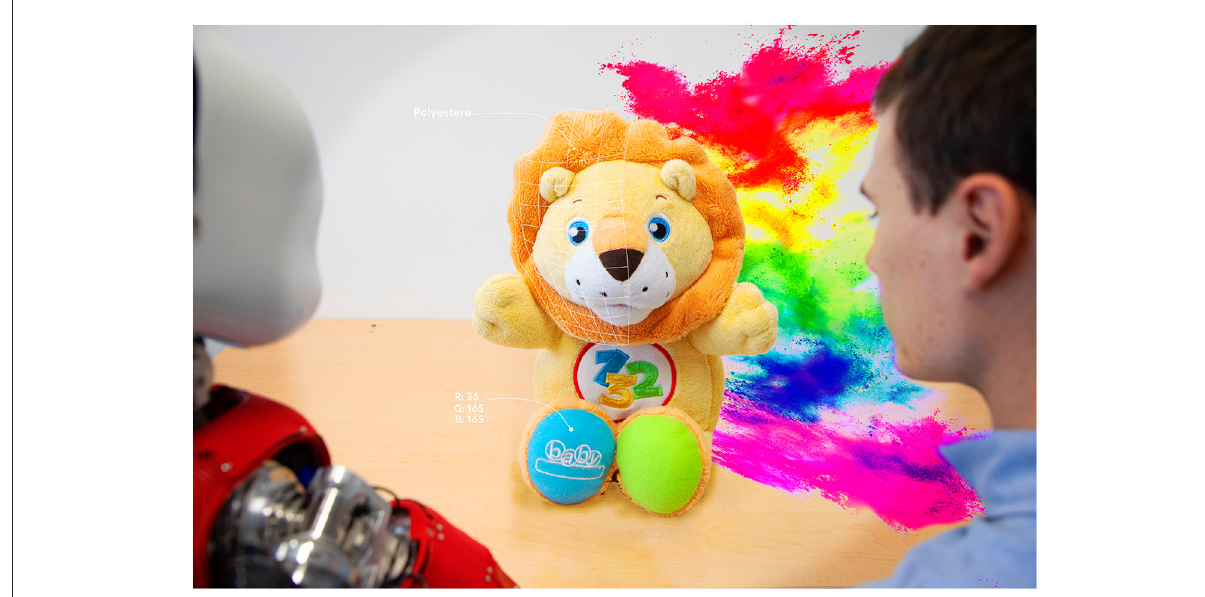
FIGURE1 Each individual’s perception results from an inferential process, where prior experience and affective states shape how we perceive others and our environment. Establishing a shared perception with another agent, be it a human or a robot, requires consideration of how the other